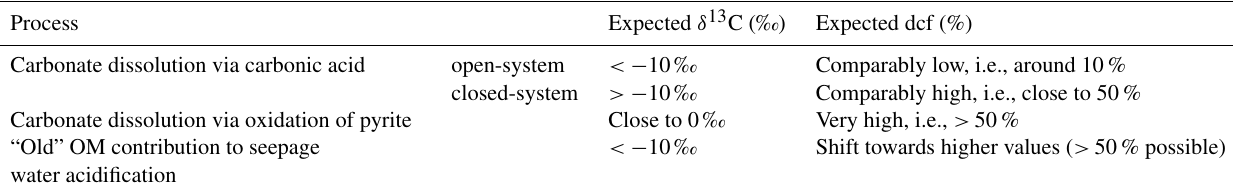
Table 1. Simplified summary of expected δ 13 C (assuming C 3 vegetation cover) and dcf values in stalagmite CaCO 3 for different dominant processes. In many karst systems various combinations of these processes complicate the interpretation. This table is a compilation of data from Fohlmeister et al. (2011b), Spötl et al. (2016) and Therre et al.